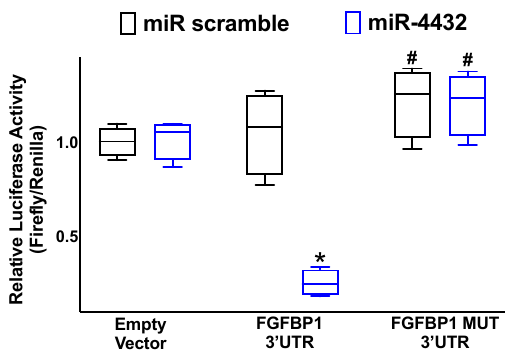
Figure 4. miR-4432 targets FGFBP1. Luciferase activity was quantified in hBMECs forty-eight hours after the transfection, utilizing the vector without FGFBP1 3 ′ -UTR (“Empty Vector”), the vector that included the WT FGFBP1 3 (cid:48) -UTR (“FGFBP1 3 (cid:48) -UTR”), and the vector that included the mutated form of the FGFBP1 3 (cid:48) -UTR (“FGFBP1 MUT 3 (cid:48) UTR”); a miR-scramble (non-targeting miR) was used as an additional control. All the assays were carried out in quadruplicate; the graphs indicate the median and the 5th to 95th percentiles; *: p < 0.01 vs. miR-scramble; #: p < 0.05 vs. FGFBP1 3 (cid:48)